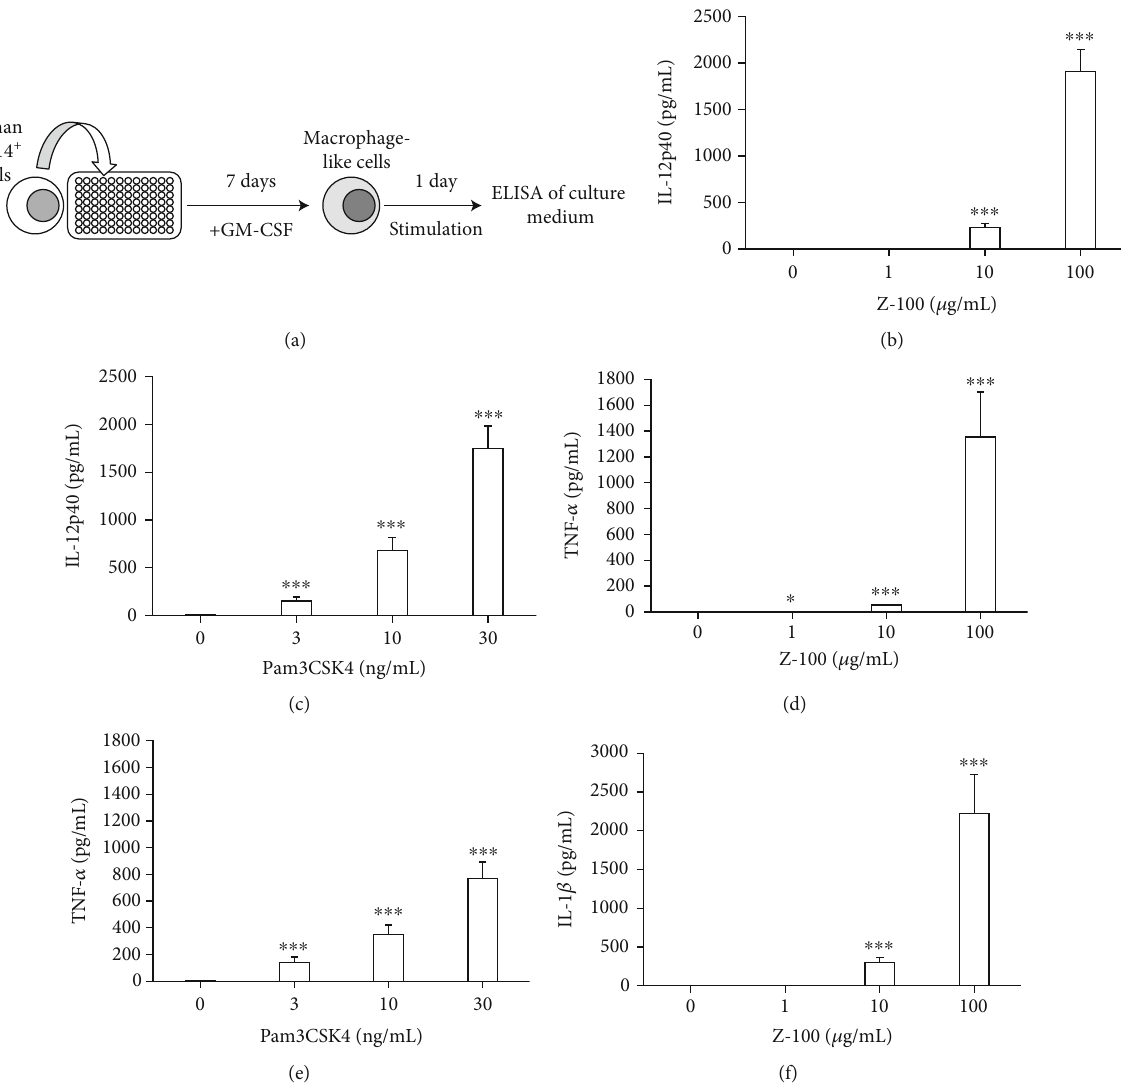
Figure 2: Cytokine production from human CD14 + cells after stimulation with Z-100. (a) Schematic of the experimental design. Human CD14 + cells were cultured with GM-CSF for 7 days before being stimulated for 24 hours. (b – f) Cytokine concentration in the culture supernatant of human CD14 + cells after stimulation with Z-100 (b, d, f; 1, 10, or 100 μ g/mL) or Pam3CSK4 (c, e; 3, 10, or 30 ng/mL). Symbols indicate a signi fi cant di ff erence compared with the 0 μ g/mL (saline) group; ∗ P < 0 : 05 , ∗∗∗ P < 0 : 001 (Steel ’ s multiple comparisons test). Data show the mean ± S : E : ; n = 12 per group, pooled from 3